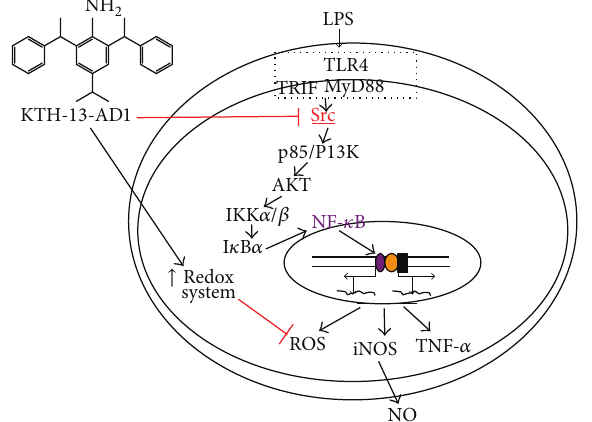
Figure 5: The putative inhibitory pathway of macrophage-mediated inflammatory signaling responses, as suppressed by